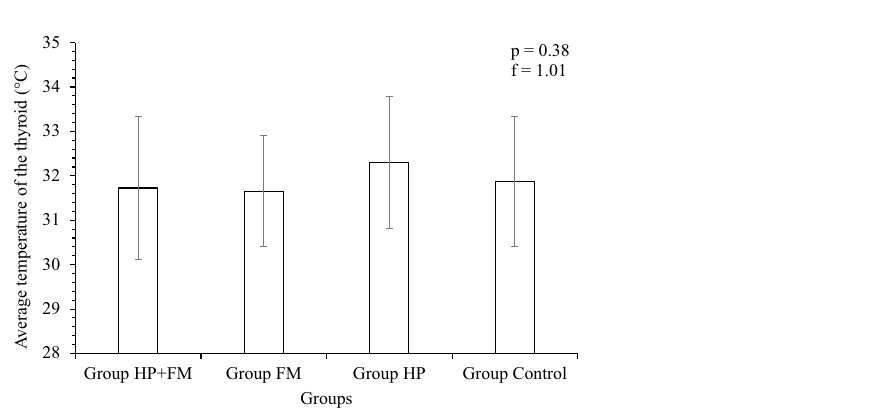
Figure 3. Points used to calculate the average temperature difference (Δ1) between the Tm of thyroid region and BAT.